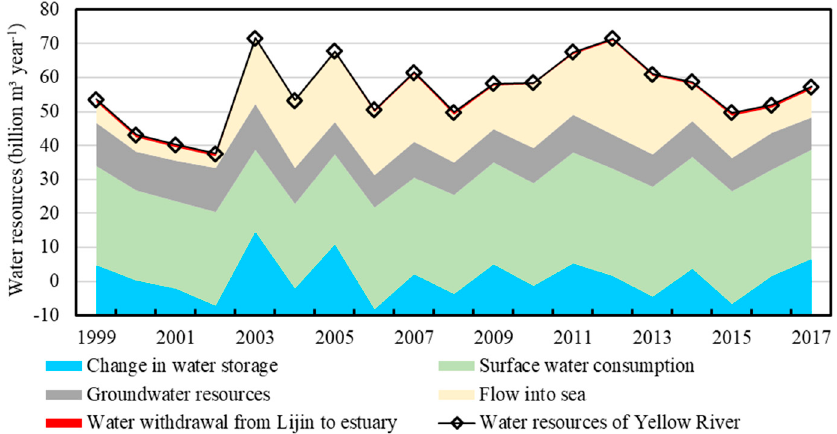
Figure 2. The total water resources of Yellow River.